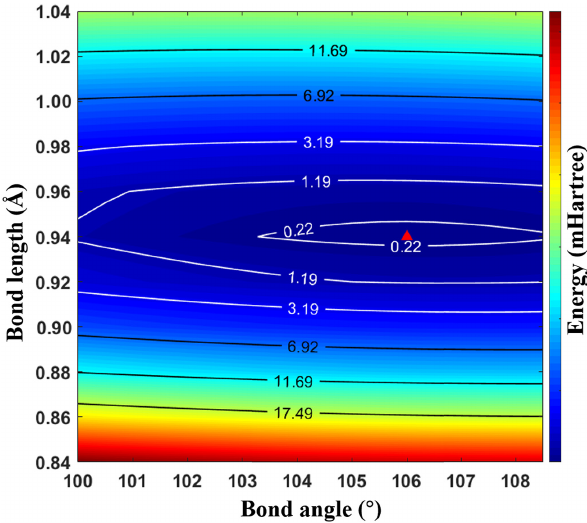
FIG. 2. Two-dimensional DW/UCCSD potential energy sur- face of H 2 O. Color representation of the energy is depicted by the color bar on the right and the energy of the optimized structure, marked by the red triangle, is set to